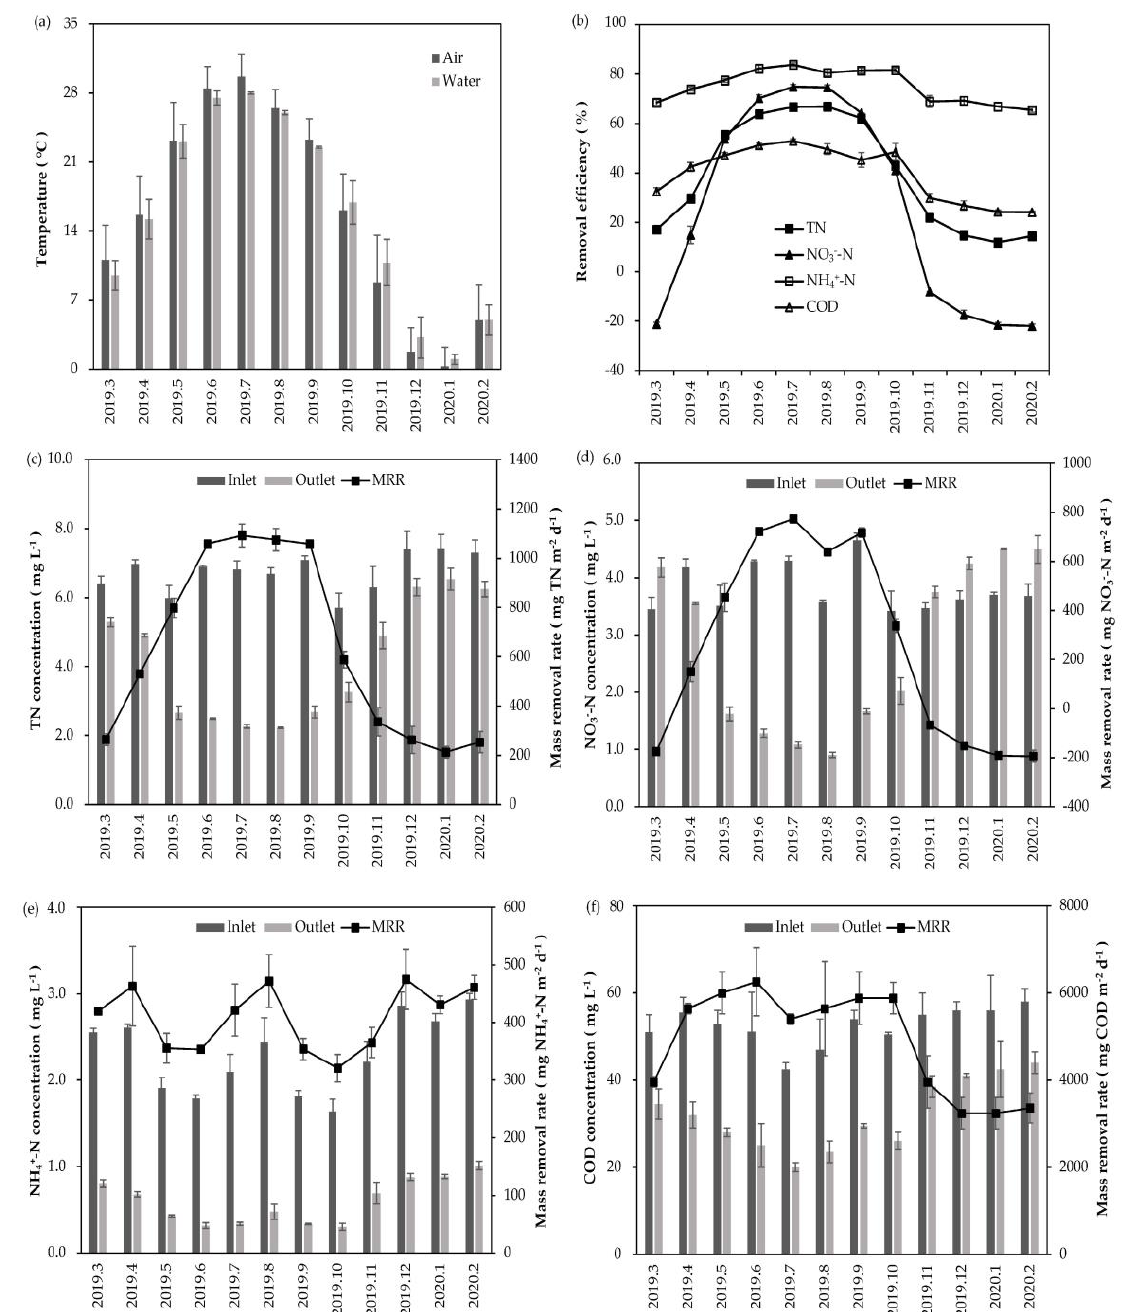
Figure 2. Data for the multi-stage surface flow constructed wetland: ( a ) temperature, ( b ) removal efficiencies (REs) for pollutants (TN, NO 3 − -N, NH 4+ -N, and COD), and ( c – f ) influent and effluent concentrations (TN and NO 3 − -N and NH 4+ -N and COD) and mass removal rates (MRRs) from March